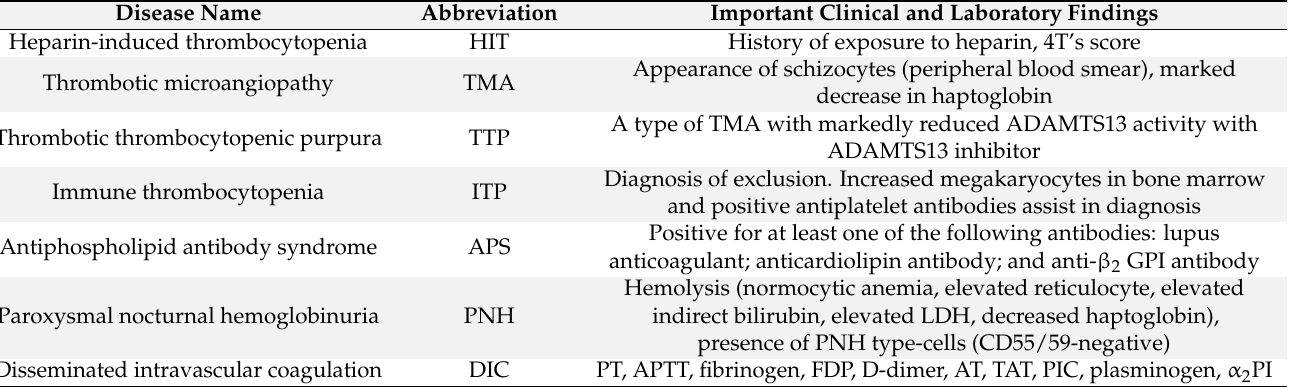
Table 3. Diseases that should be differentiated from VITT and their key